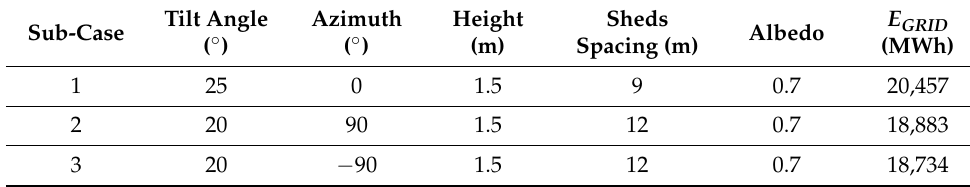
Table 7. Data for case 2: Bitola, Macedonia.